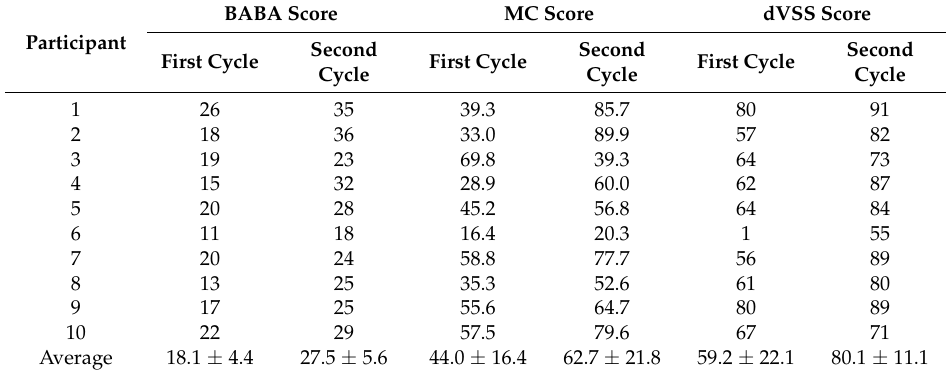
Table 1. The BABA, MC, and dVSS scores of the ten participants when they conducted two cycles of standardized BABA training model and dVSS tasks.